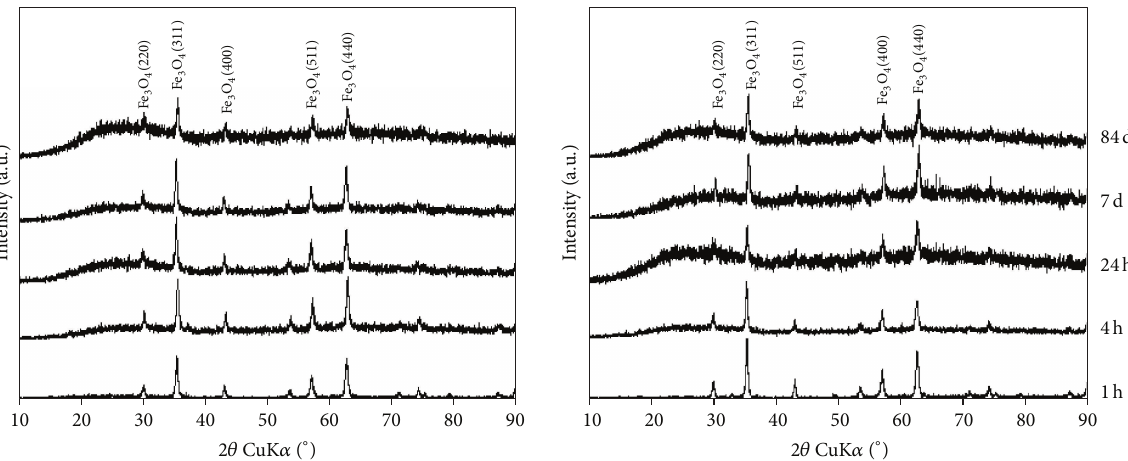
Figure 7: X-ray diffraction (XRD) spectra (for the range of 10–90 ∘ 2 𝜃 ) recorded for the mine water batch systems containing as-formed (LHS) and vacuum annealed (RHS) nano-Fe 3 O 4 extracted at reaction times of 1 h, 4h, 24h, 7d, and 84